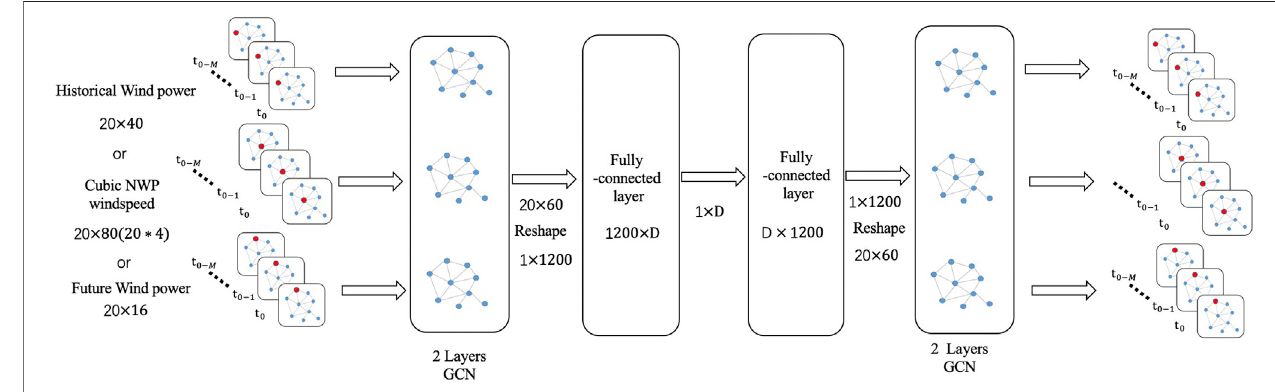
FIGURE 2 | The architecture of graph autoencoder.